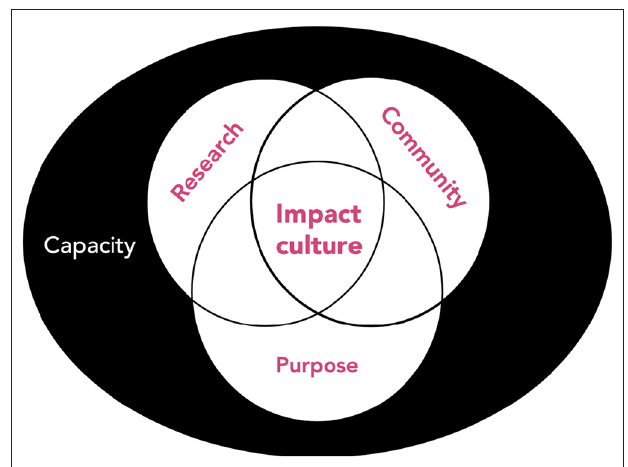
FIGURE 1 | Conceptual framework showing how impact culture emerges at the intersection between: the purpose of an individual or institution; rigorous, ethical, and action-orientated research; and social capital between academic and non-academic communities, in the context of sufficient internal capacity to facilitate each of the three pillars of a healthy impact culture (from Reed,